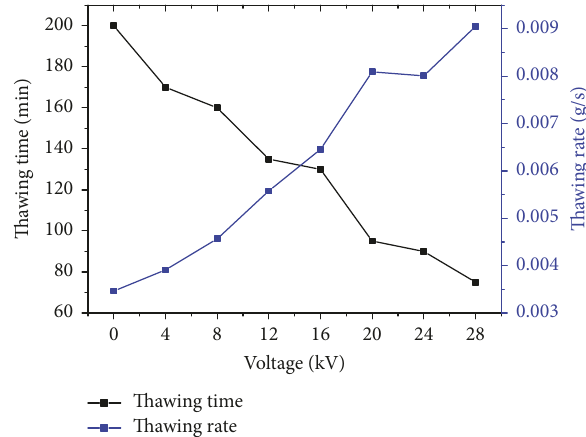
Figure 2: Thawing time and thawing rate of frozen tofu in different